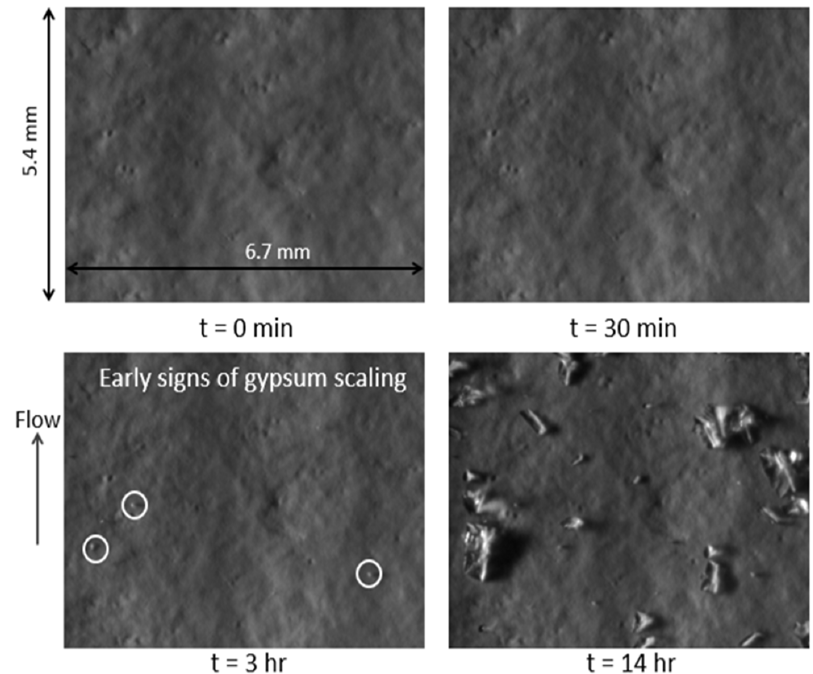
Figure 6. RO membrane surface images during desalination of RO feed water pretreated via a fil- tration train that included UF (configuration B, Figure 2) without antiscalant dosing. PFRO operat- ing conditions: crossflow velocity = 4.5 cm/s, initial permeate flux = 33 L/m 2 -hr (19 gallons/ft 2 -day), and initial SI g,m ~ 2 corresponding to equivalent RO plant recovery of 63%.